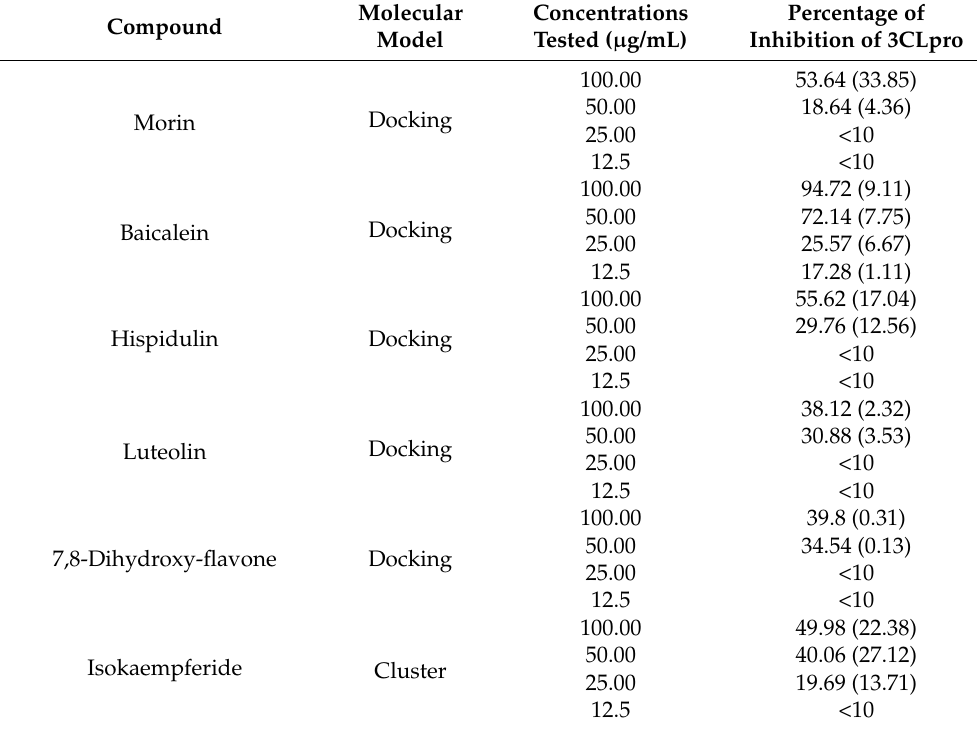
Table 2. Enzymatic anti-3CLpro activity of selected